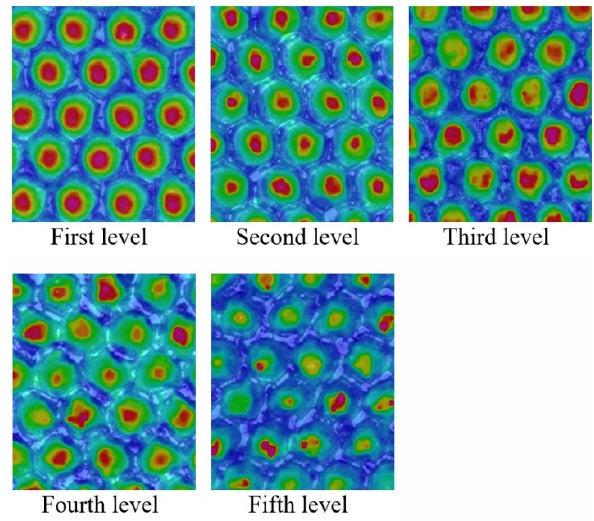
Figure 5. Cell clogging levels.